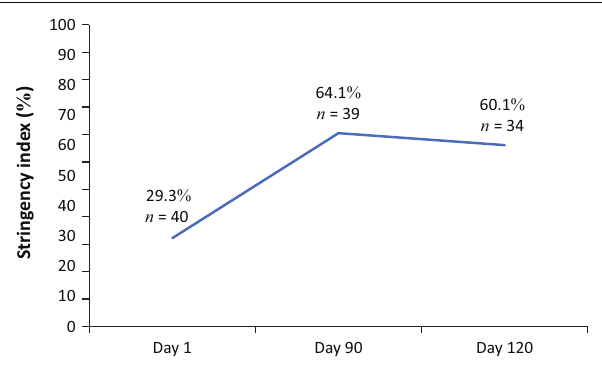
FIGURE 1: Average stringency index of 42 WHO African Region countries at Day 1 (28 February 2020 – 15 May 2020); and Day 120 (120 days from the date of the first reported case; range: 26 June 2020 – 11 September